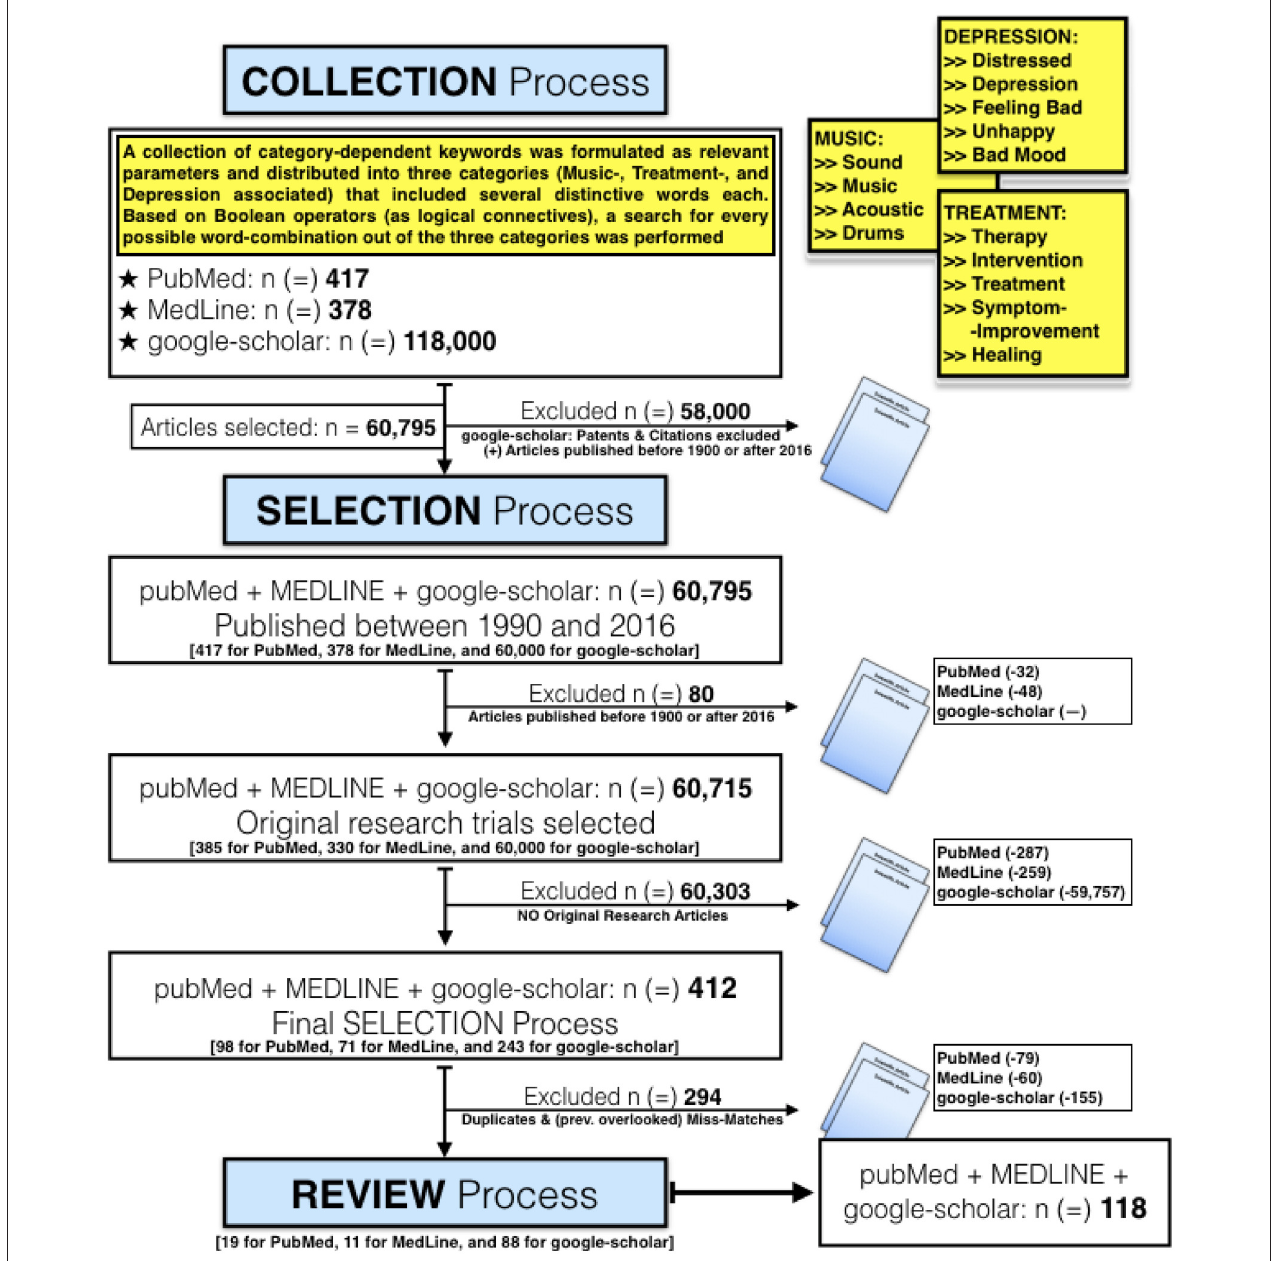
FIGURE 2 | Overview of our Collection, Selection, and Review Process (idea, concept and creation of this Figure by Leubner). Initially, the total number of retrieved results was 118,000 as far as google-scholar was concerned. Analysis was complicated by the disproportionately high number of results from google-scholar. Therefore, we decided to narrow down this initial search query to a period from 1990 up to 2016, and reduced the results from google-scholar to 60,000 this way. Compared to the other two search engines, this process was done two steps ahead. At google-scholar we excluded patents as well as citations in the initial window for our search results. Unfortunately search options are very limited, and though we retrieved at first this overwhelming number of 118,000 results!. Some keywords (e.g., anxiety, pain, fear, violence) were deliberately excluded right from the beginning. This was done right at the start of our selection/search process, to prevent a systematic distortion of retrieved